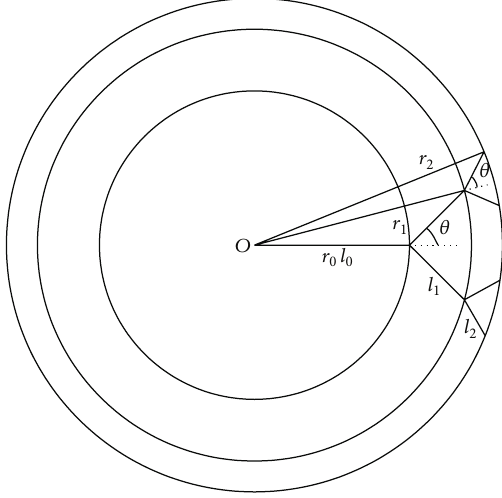
Figure 1: Dual fractal